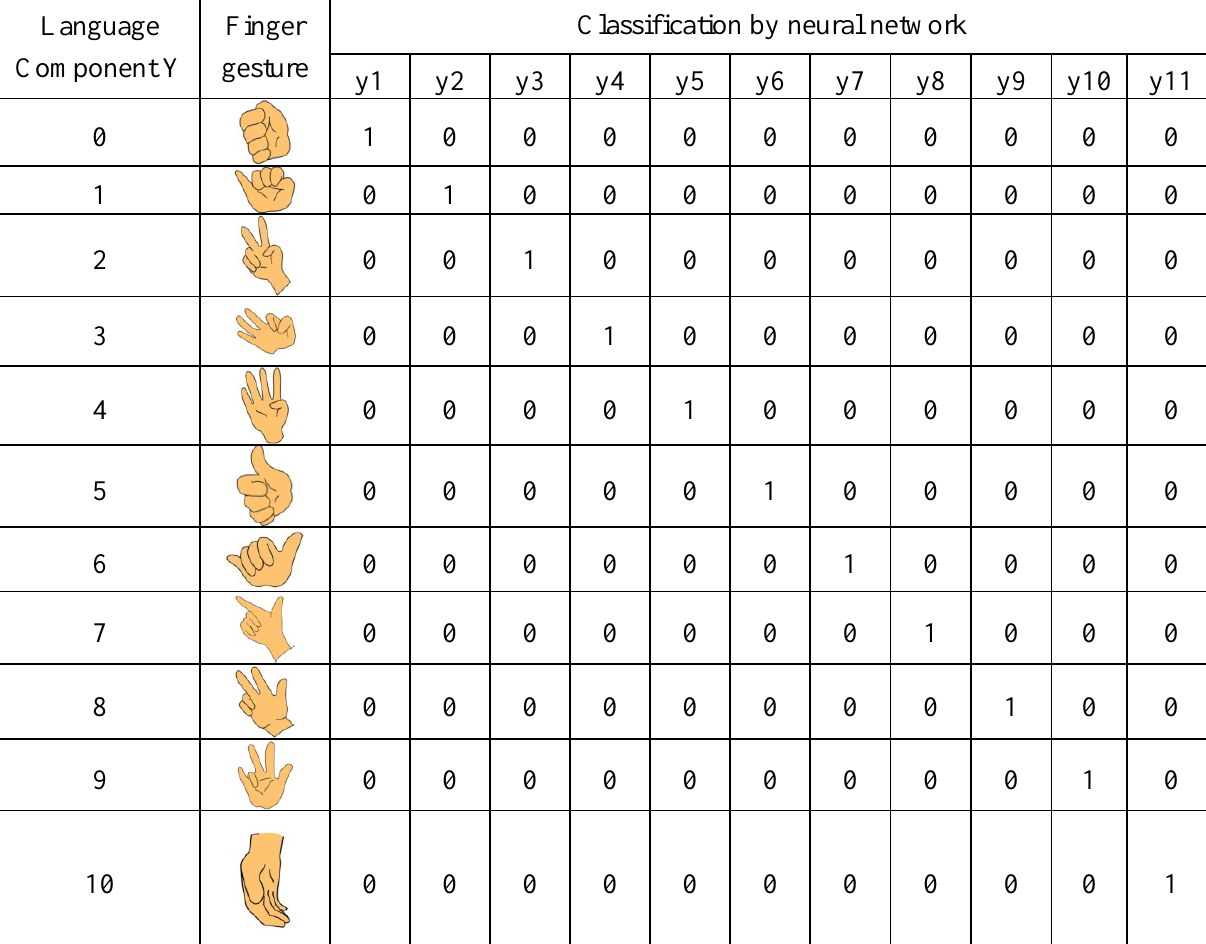
Table 1. Finger language components needing